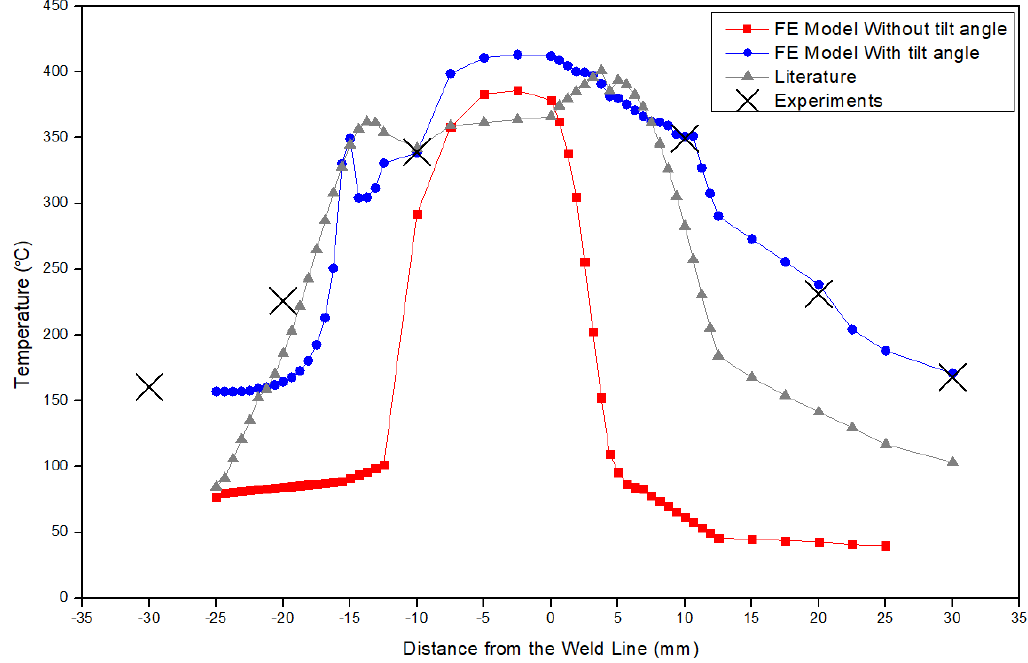
Figure 20. The cross-sectional view of the temperature with and without the tilt angle with compar- ison to the experiments and the literature